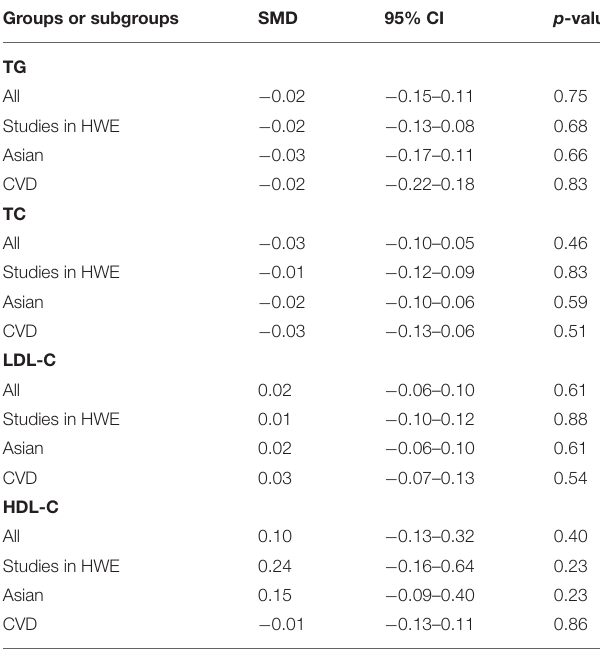
TABLE 3 | Meta-analysis of the miRNA-499a rs3746444 polymorphism with lipid levels. Groups or subgroups